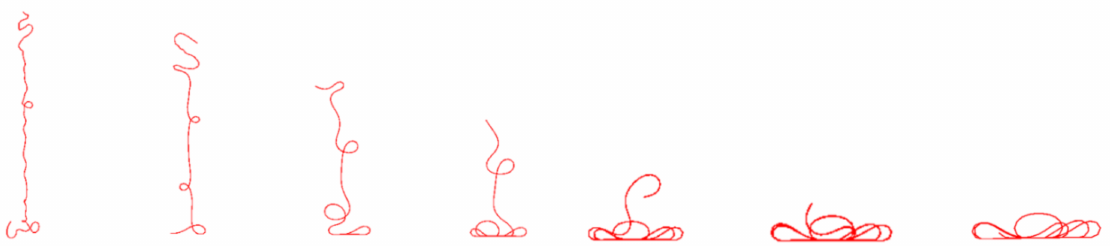
Figure 5. Configuration of a cable with the catenary calculation